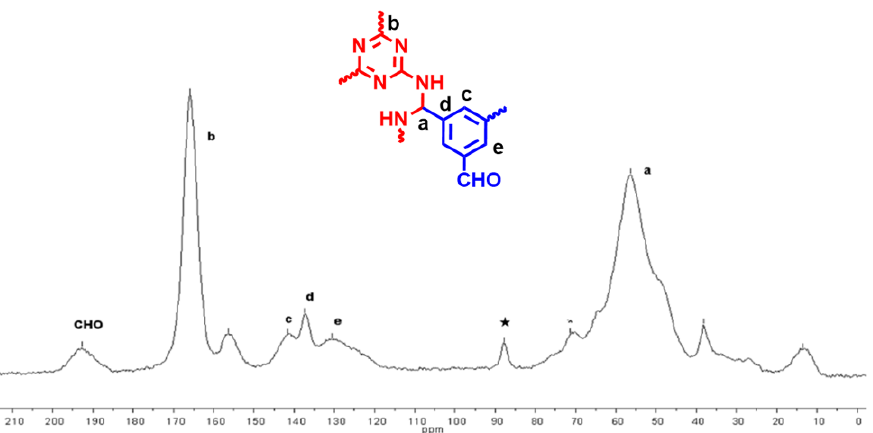
Figure 2. Solid-state 13 C CP/MAS NMR spectrum of POP, asterisks indicate peaks arising from spinning side bands.